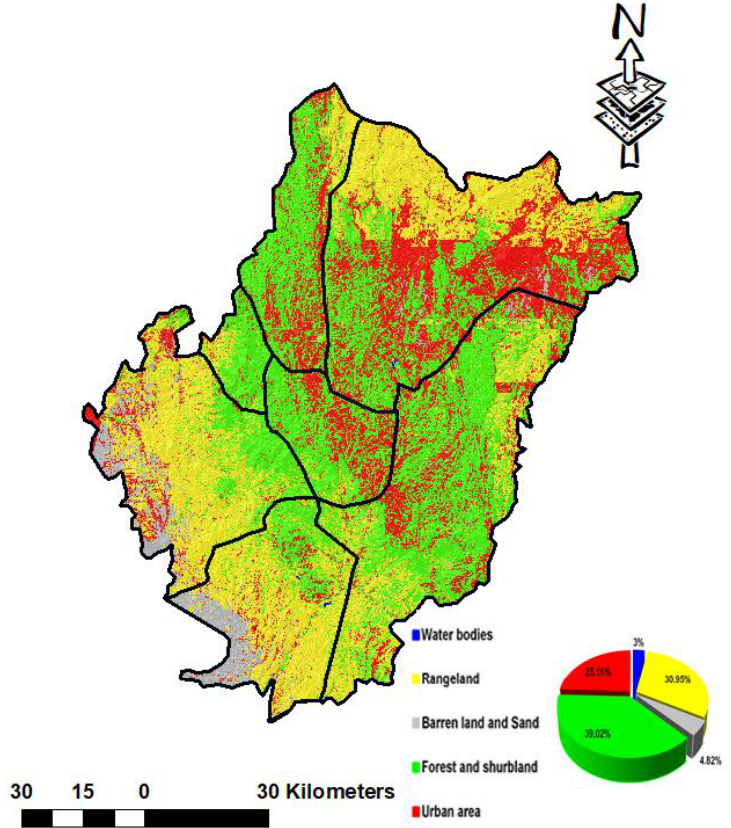
Figure 13. Predicted Land use land cover change map for the year 2047.